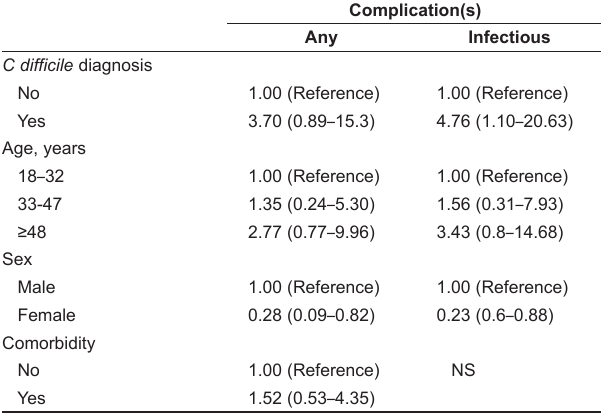
TAble 3 logistic regression results for emergent